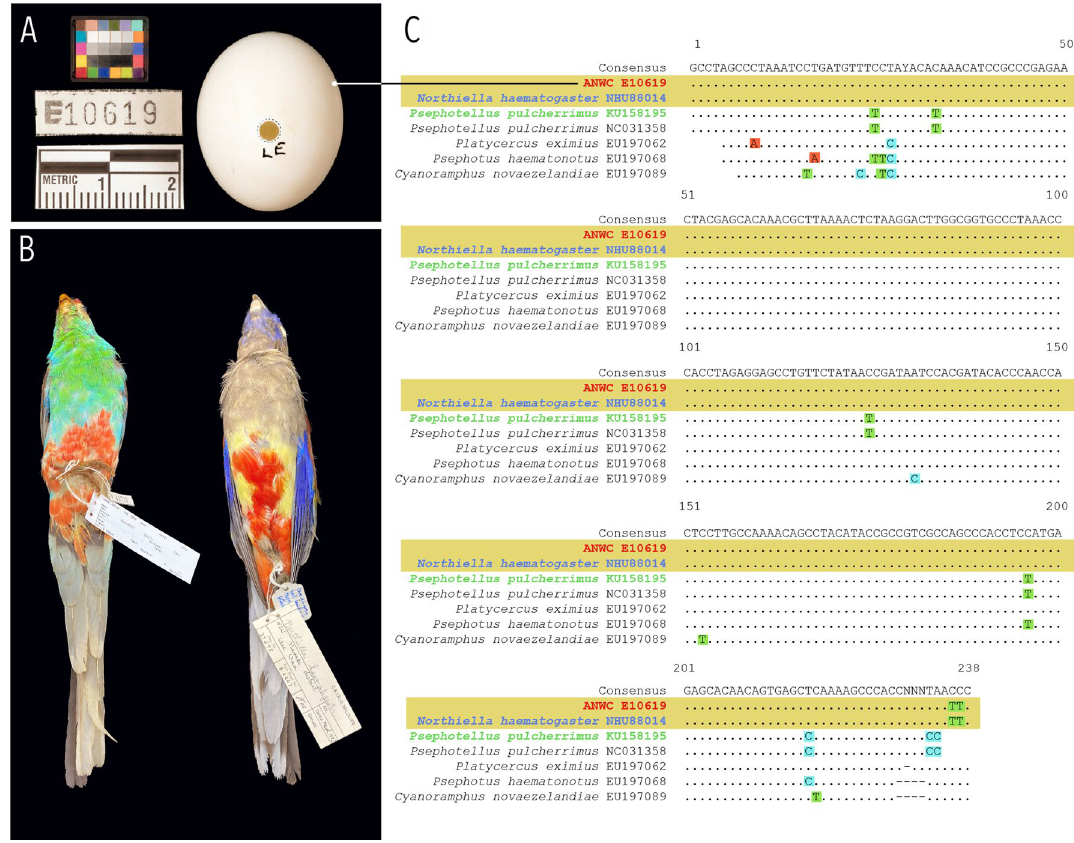
Figure 3. ( A ) photograph of putative paradise parrot ( Psephotellus pulcherrimus ) egg. The dotted line around the blow hole represents the size of the blow hole after drilling. ( B ) Image of specimens in the Australian National Wildlife Collection of the extinct paradise parrot (left) alongside an adult eastern bluebonnet ( Northiella haematogaster , right), the species to which the disputed egg (in A ) actually belongs. ( C ) An alignment of the 12SAH barcode sequenced from the eggshell specimen in question alongside genetic references from members of the tribe Platycercini. Dots represent bases identical to the consensus, and yellow shading highlights the reference sequence that is 100% identical to the eggshell specimen